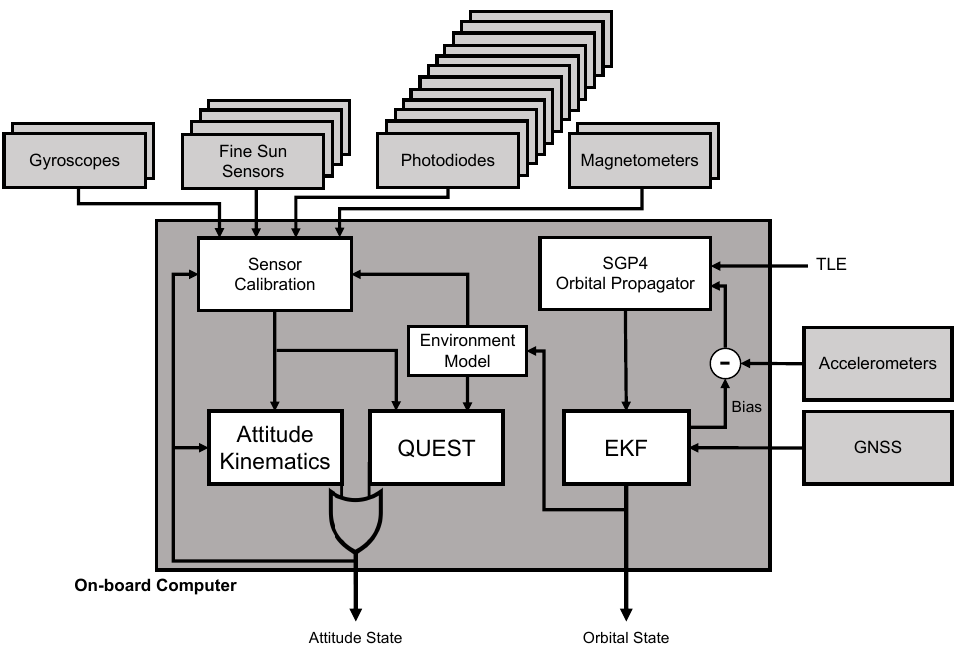
Figure 1. Sensor architecture